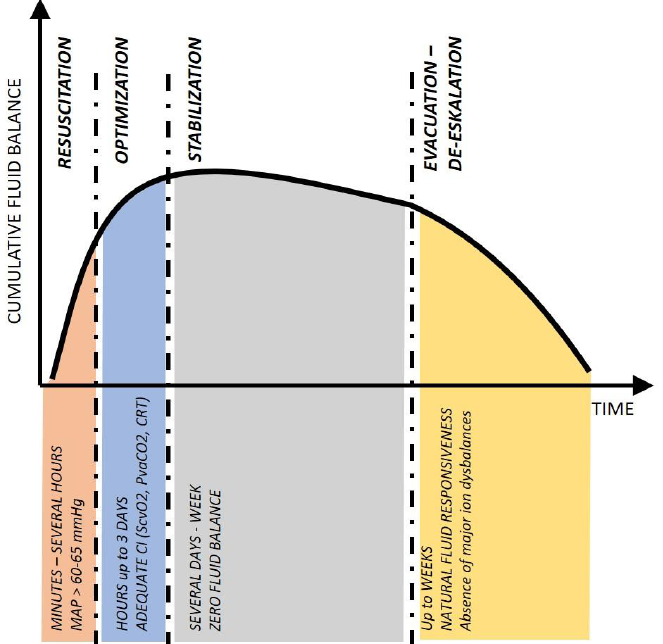
Figure 1. The ROSE concept of fluid therapy with the timing of each phase and potential treatment goals. Abbreviations: CI—cardiac index, CRT—capillary refill time, MAP—mean arterial pressure, P va CO 2 —veno-arterial difference of CO 2 , S cv O 2 —central venous oxygen saturation.